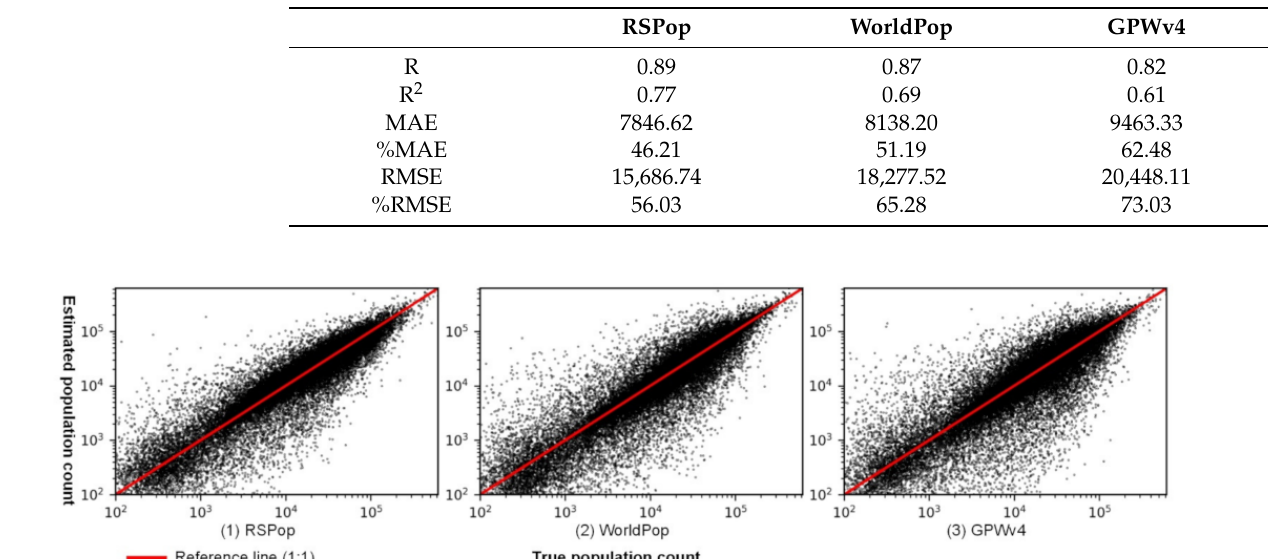
Table 1. Accuracy assessment of RSPop at town scale comparing WorldPop and GPWv4.